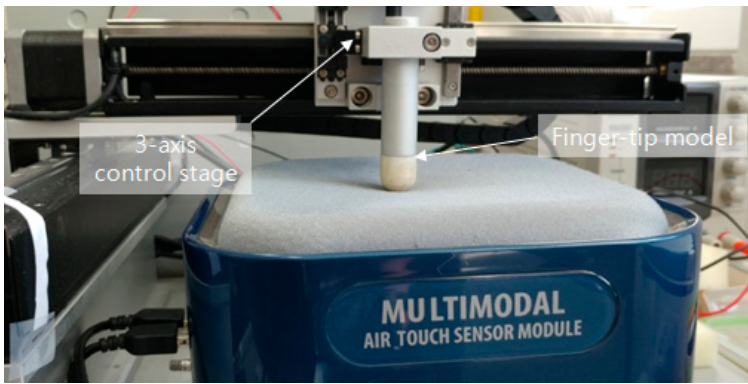
Figure 10. Experimental environment for obtaining weighted data sets.